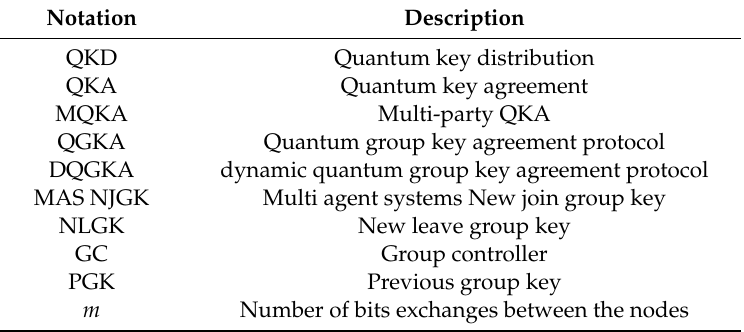
Table 1. List of acronyms of key concepts used in this